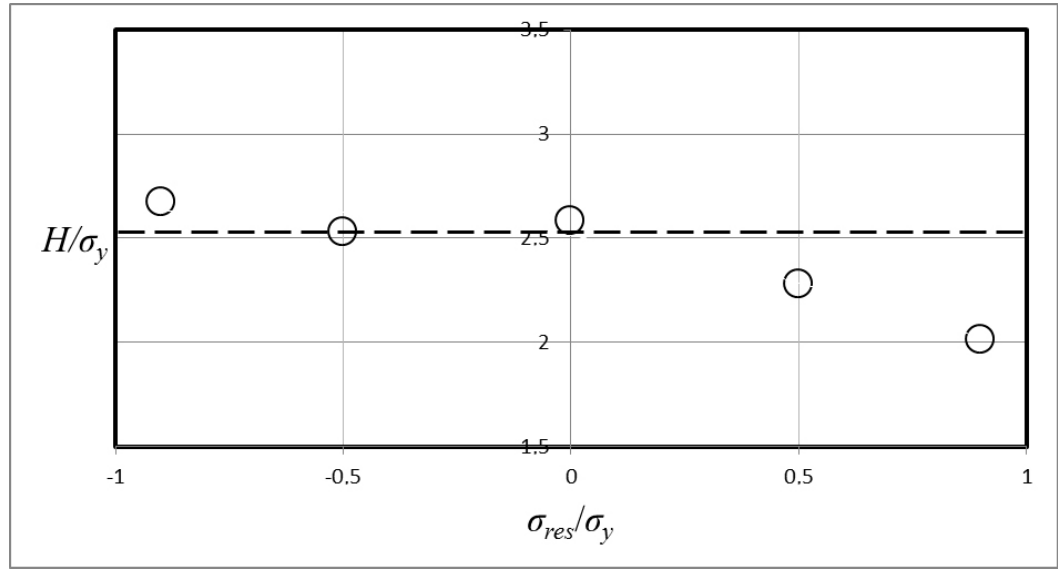
Figure 8 Figure 8. Normalized hardness, H / σ y , as a function of the nondimensionalized equi-biaxial residual stress field, σ re s / σ y , at cone indentation β = 22 ◦ . The results are pertinent to indentation of an elastic-ideally plastic material with ln Λ = 3 where Λ is defined according to Equation (1). (- - -), Equation (16). (o), numerical results for different values on σ re s / σ y . The results are taken from Rydin and Larsson